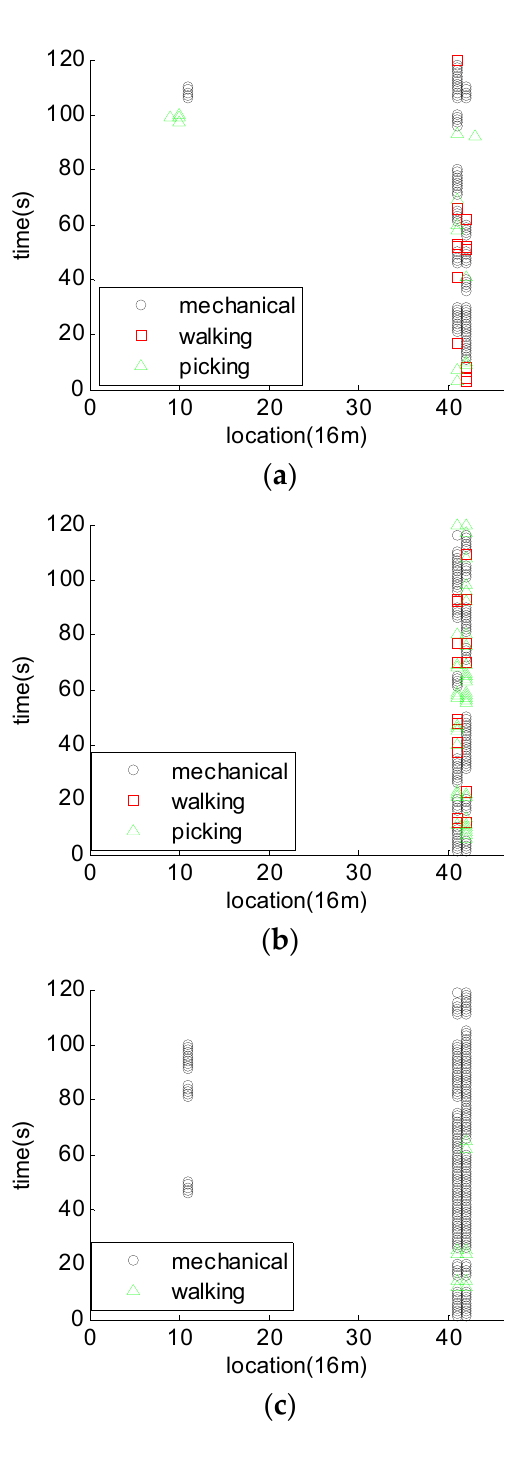
Figure 13. The identification results of mechanical drilling signals. ( a ) The first group of mechanical drilling signals; ( b ) The second group of mechanical drilling signals; ( c ) The third group of mechanical drilling signals.